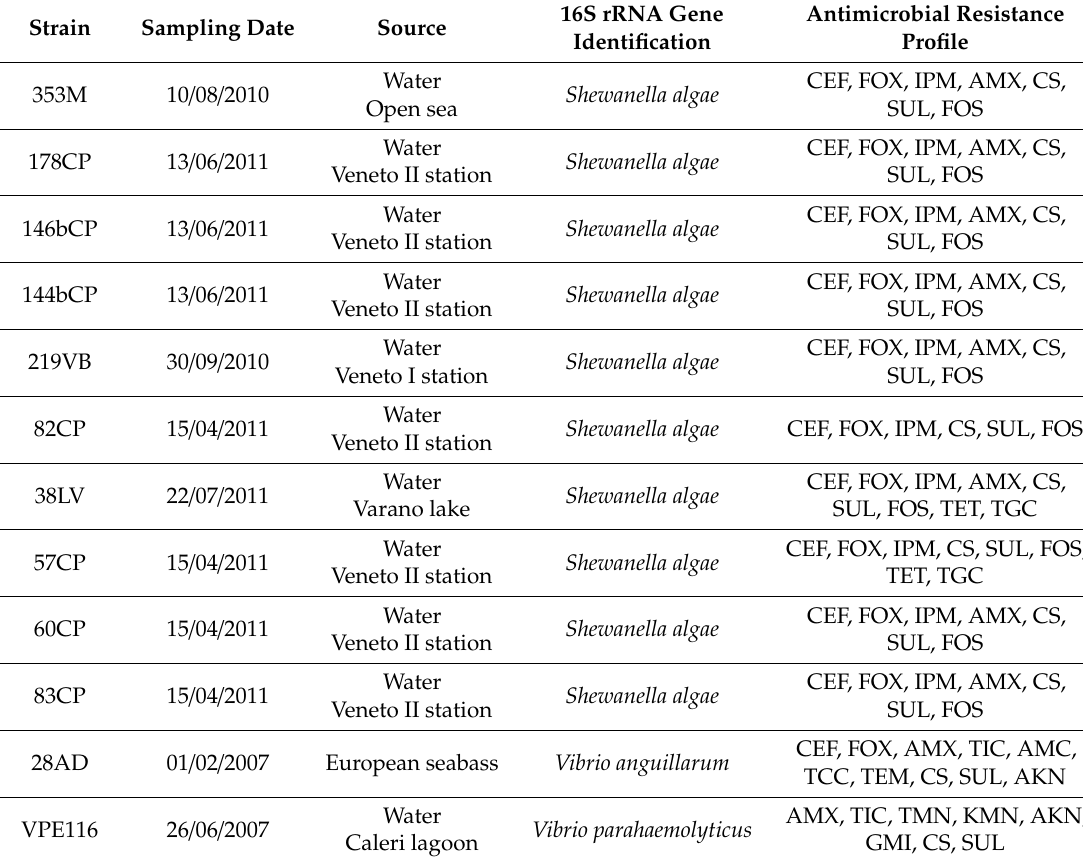
Table 1. List of multidrug-resistant (MDR) marine isolates under study. Sampling dates, sources, species identification and antimicrobial resistance profiles are reported for each